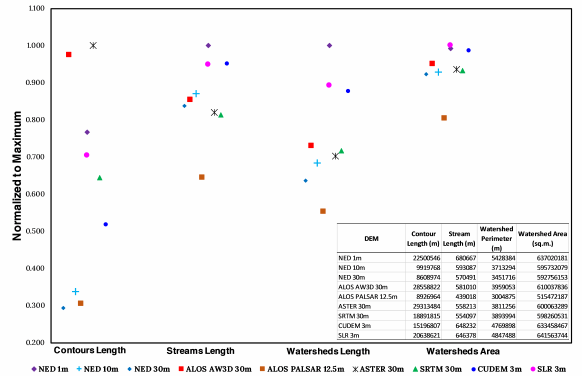
Figure 7. Cumulative sum of stream length, watershed area, watersheds perimeter length and contour length The CUDEM, NED 1m, and SLR showed more stream length